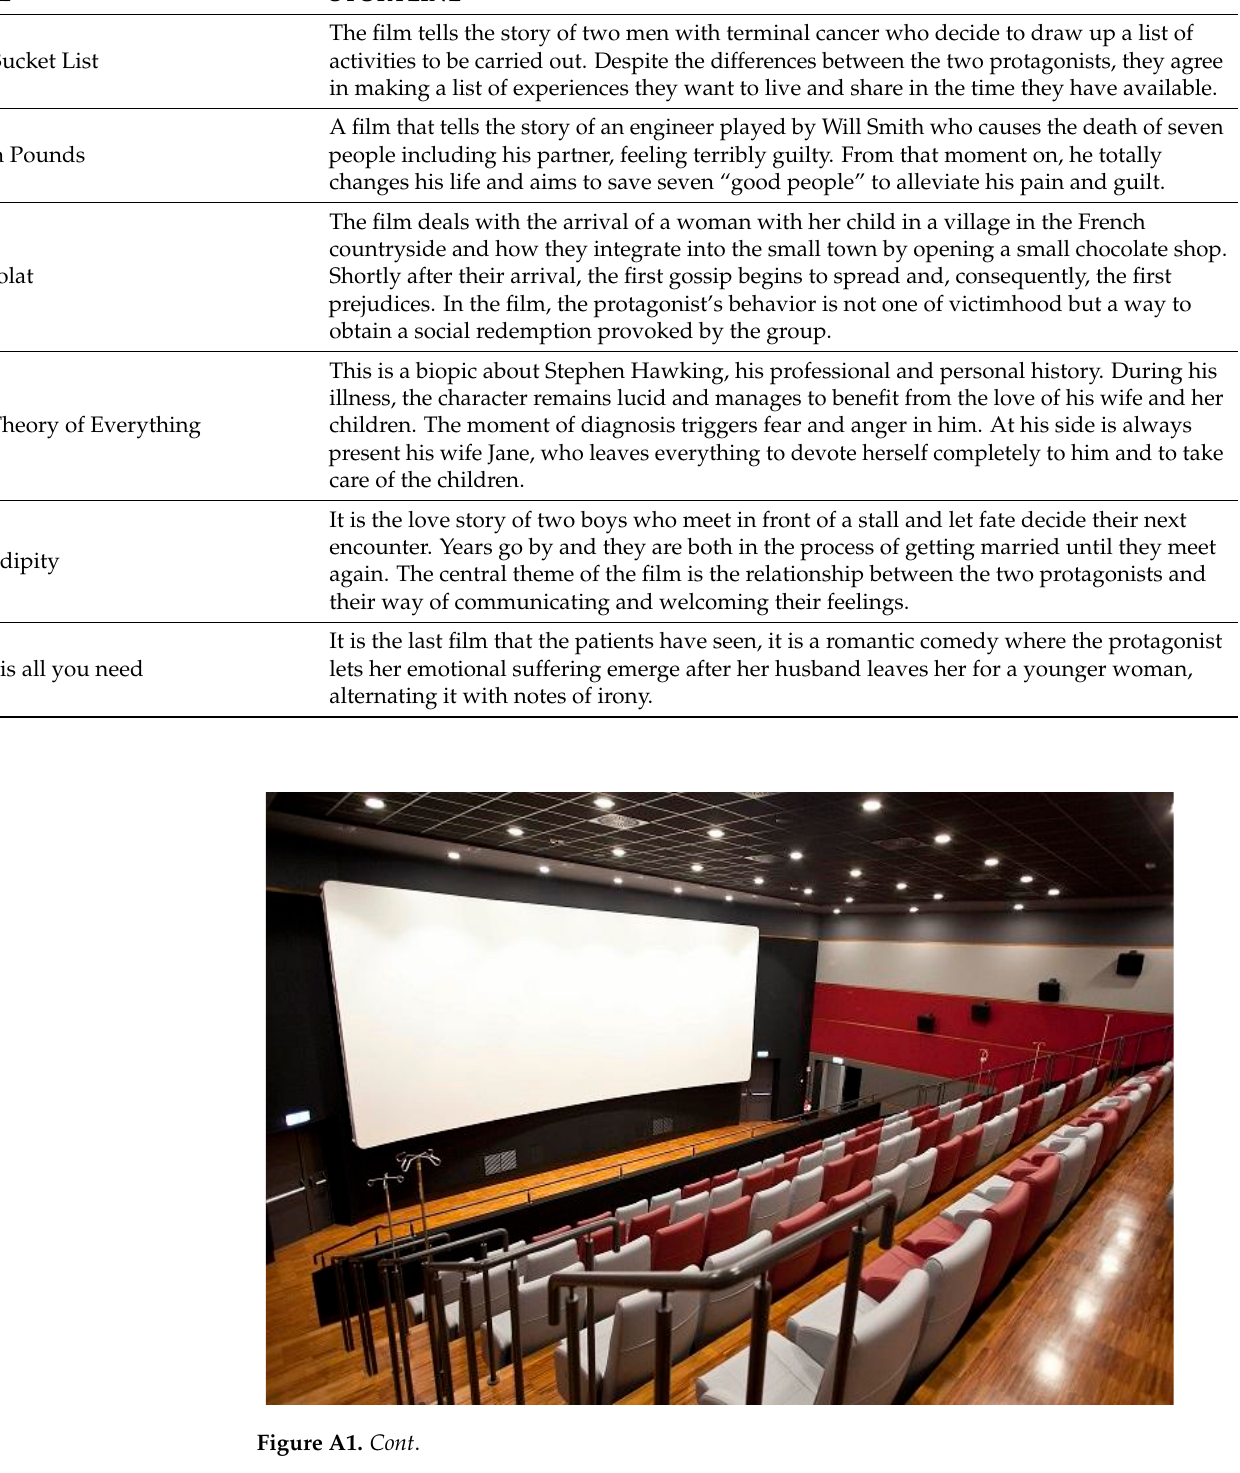
Figure A1. Medicinema Hall at Policlinico Agostino Gemelli, Rome. Appendix B. Filmography •